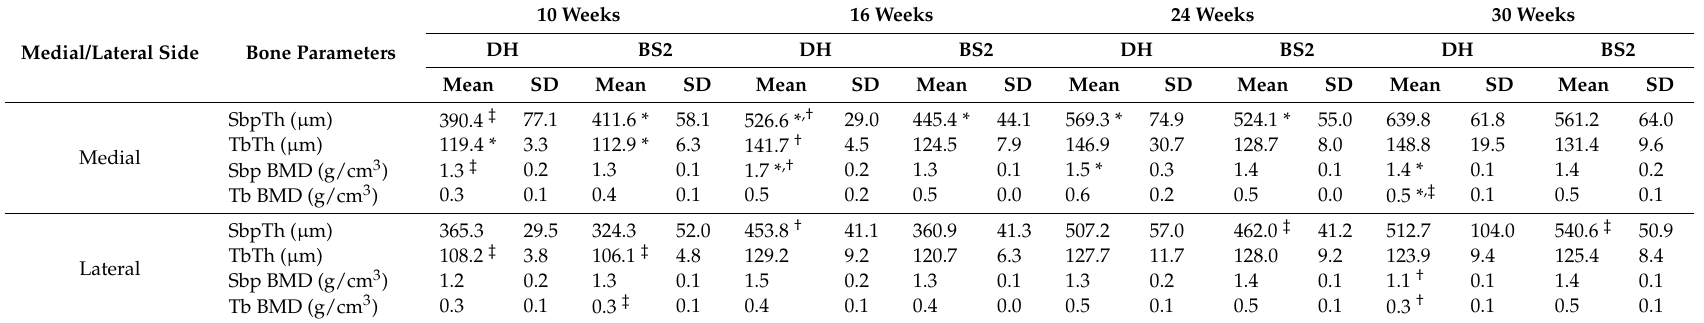
Table 1. The mean of subchondral bone thickness and density in DH and BS2 during the 30 weeks study